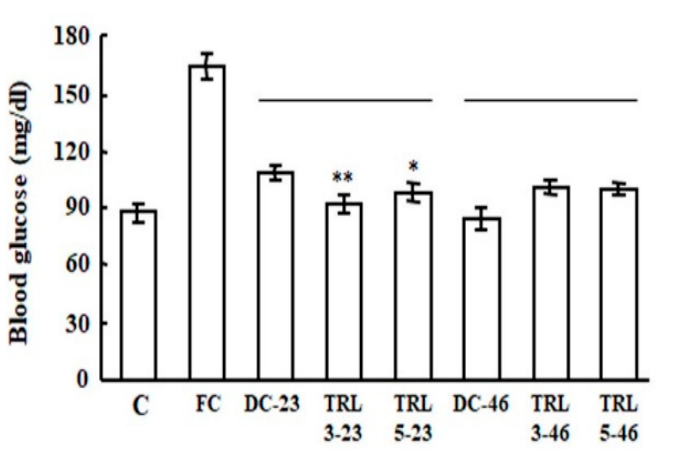
Figure 4. Effects of the transgenic rice on blood glucose levels. The blood glucose levels were